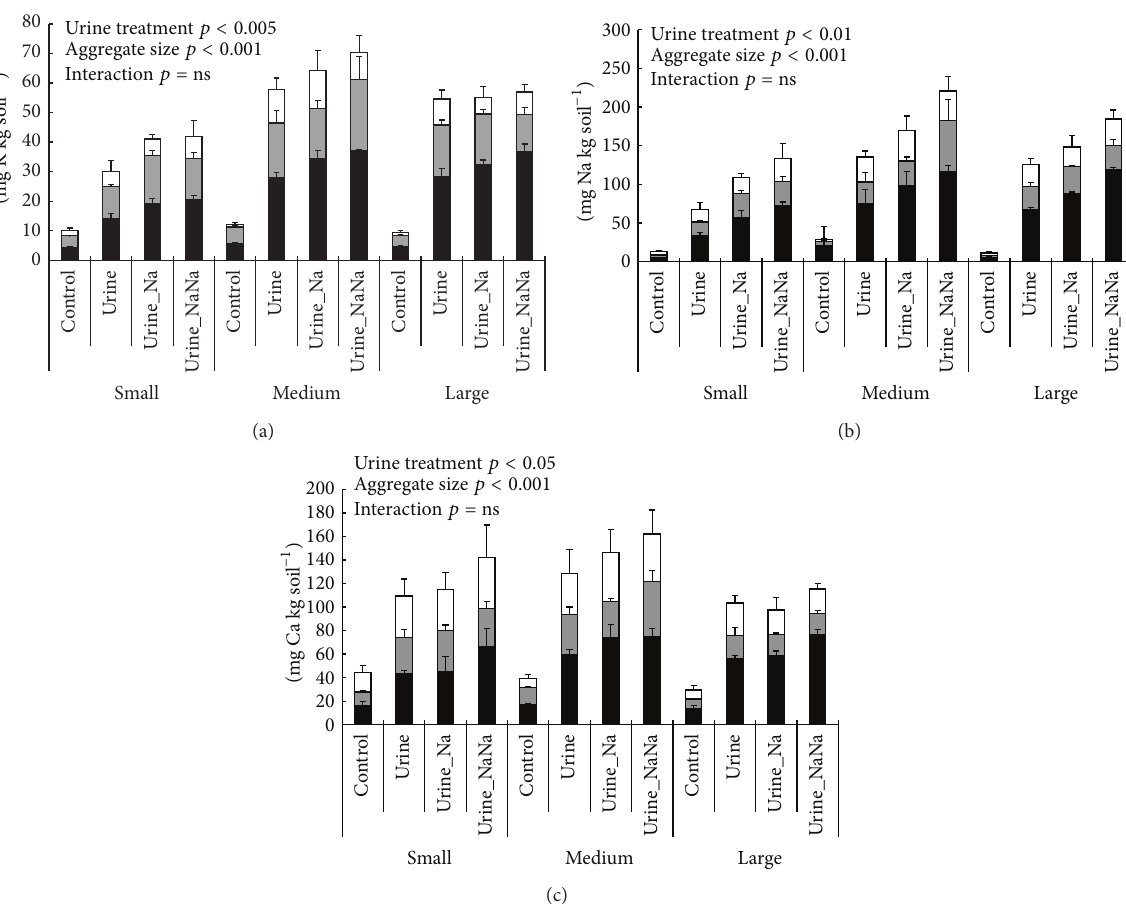
Figure 6: The amount of nutrient loss from soil cores after simulated rain events. Different coloured bars indicate the nutrient loss after each simulated rain treatment. The loss of (a) K + , (b) Na + , and (c) Ca 2+ was shown in separate figures. The error bars indicate standard deviations ( 𝑛 = 3